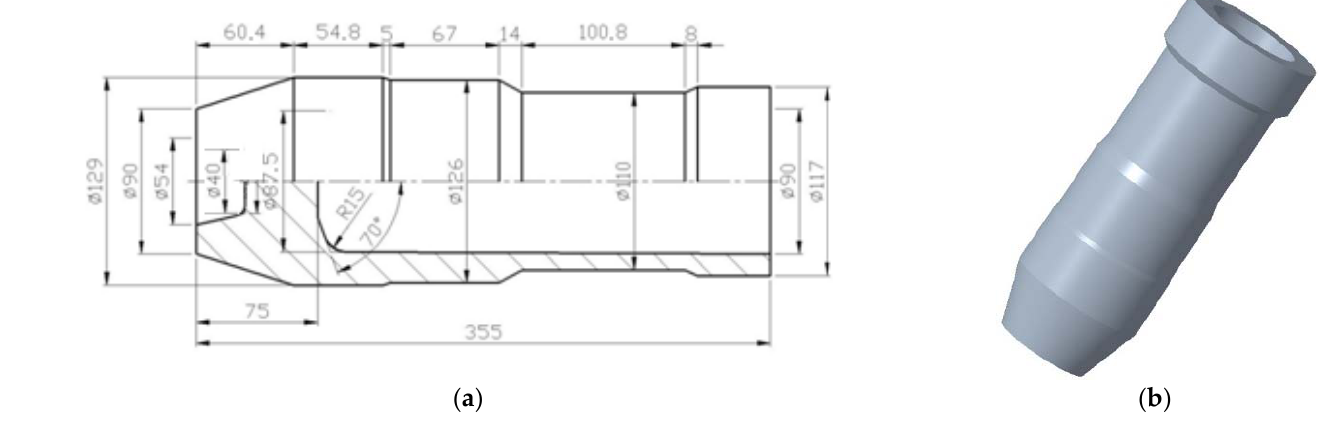
Figure 1. Cup with curved rotary profile: ( a ) schematic diagram; ( b ) 3D model.